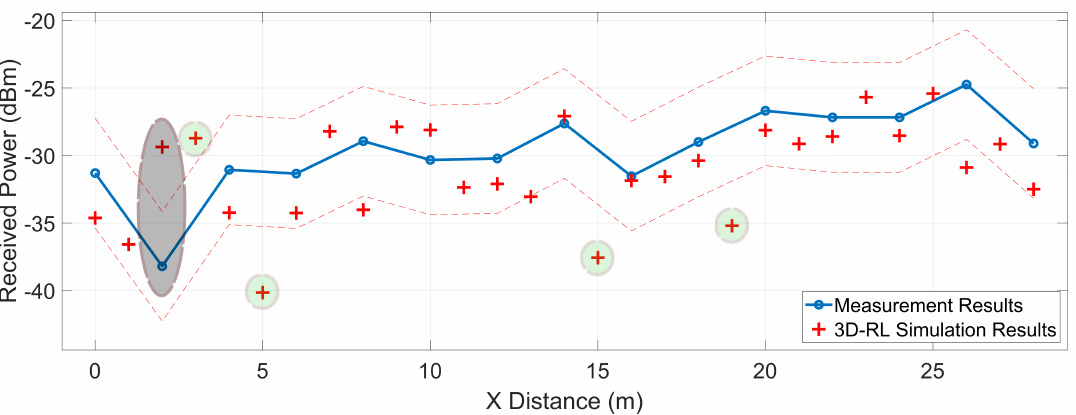
Figure 17. Measurement results for the opposite sidewalk ( Pc 1 to Pc 15 ) and 3D-RL simulation results for these spatial